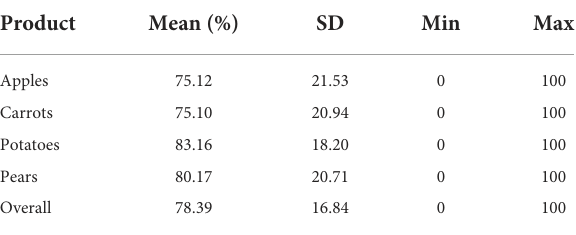
TABLE 2 Descriptive statistics on the percentage of consumers’ WTP for each suboptimal food